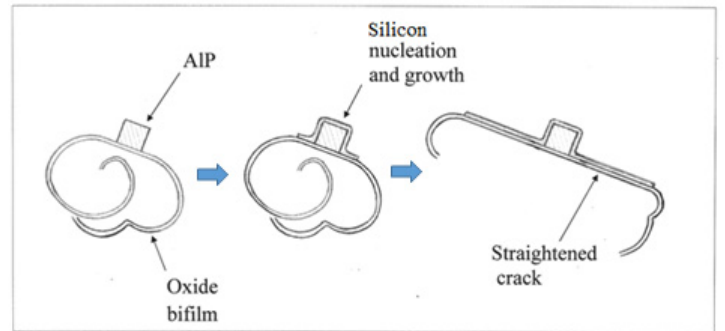
Figure 7. Nucleation of an AlP particle on a compact bifilm,.which in turn nucleates Si, whose planar growth straightens the bifilm.